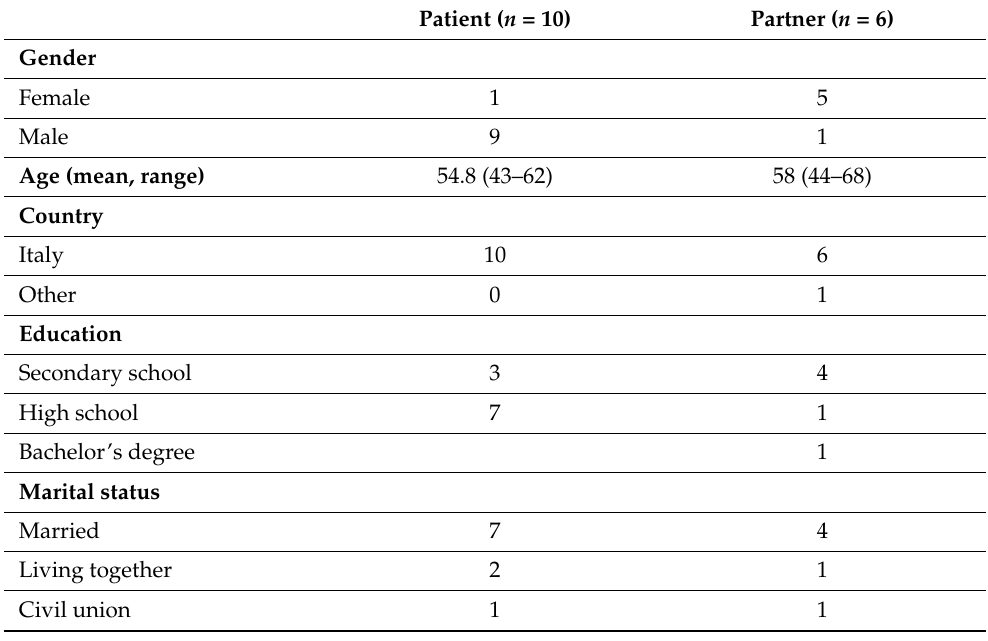
Table 1. Social-demographic characteristics.